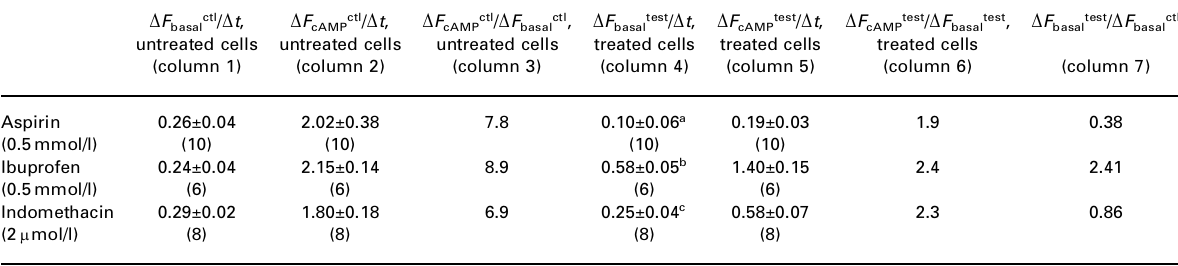
Table 2. Analysis of MEQ fluorescence in T84 cells D F basalctl / D t , untreated